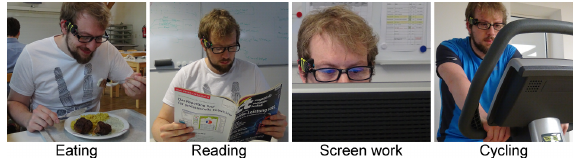
Figure 3: WISEglass worn during a subset of the